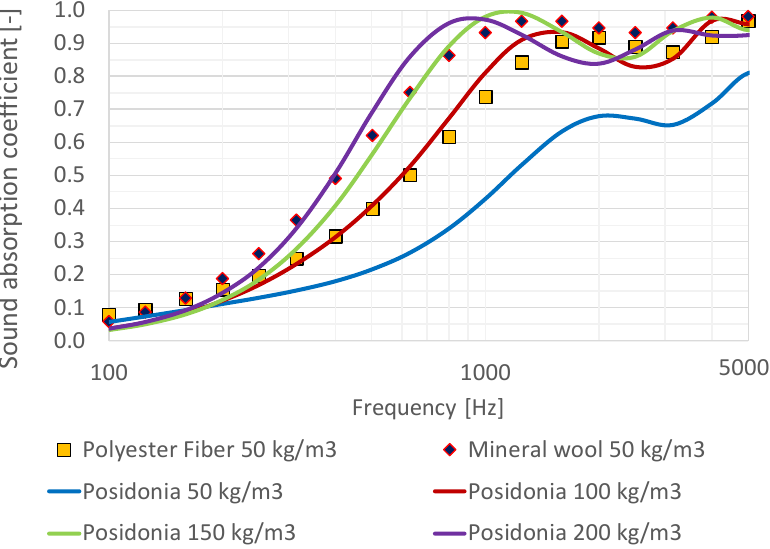
Figure 9. Absorption coefficient of Posidonia fibers as density varies (solid lines) and of two tradi- tional sound-absorbing materials (dots: polyester fiber and mineral wool).